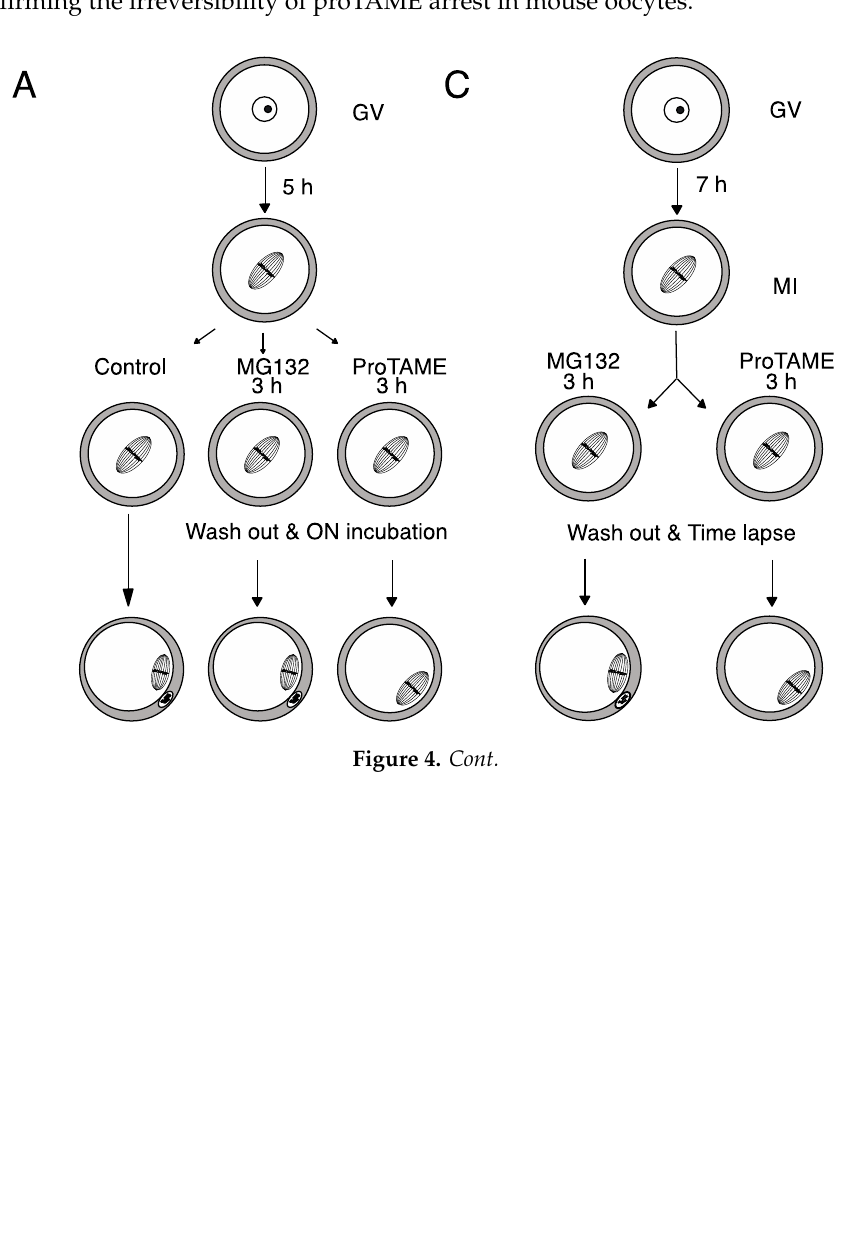
Figure 4 . ProTAME-induced arrest in mouse oocytes is irreversible. ( A ) Germinal vesicle (GV) oocytes were matured for 5 h and then divided into three groups: the control group, MG132-treated group and proTAME-treated group. The control group was incubated overnight in M16 media. MG132 and proTAME groups were exposed to inhibitors for 3 h, washed out and incubated overnight in M16 media. The frequency of PBE was scored following overnight (ON) incubation. ( B ) The frequency of PBE in control oocytes ( n = 70), oocytes in 10 μ M MG132 ( n = 79) and oocytes in 5 μ M proTAME ( n = 81) was scored. A total of 97% of control cells, 99% of cells after MG132 and 0% of cells after proTAME extruded polar bodies (PBs). Data were obtained in three independent experiments. The difference between the control and MG132 is not statistically significant ( α < 0.05; p = 0.6008). The difference between the control and proTAME is statistically significant ( α < 0.05; *** p < 0.0001). ( C ) GV oocytes were matured for 7 h and then divided into two groups; one was treated with MG132 and the other with proTAME for 3 h and subsequently cultured in M16 without inhibitors while PBE was monitored by live cell microscopy ON. ( D ) The frequency of PBE in oocytes after 10 μ M MG132 ( n = 43) and 5 μ M proTAME ( n = 51) was scored. A total of 93% of cells after MG132 and 0% of cells after proTAME extruded PBs. Data were obtained in two independent experiments. The difference between both groups is statistically significant ( α < 0.05; *** p < 0.0001).